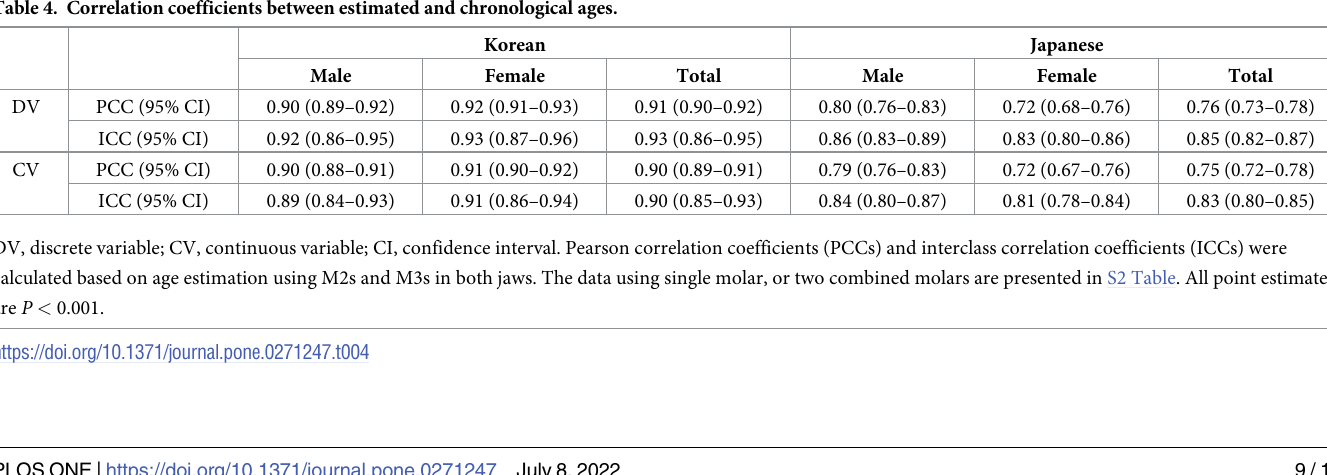
Table 4. Correlation coefficients between estimated and chronological ages.